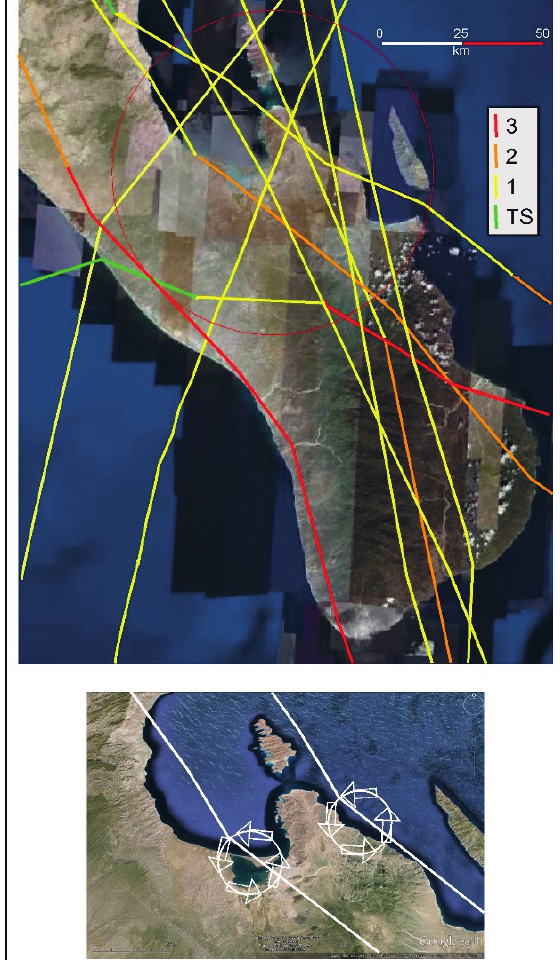
Figure 9. Hurricane history for the La Paz area. Displayed are the tracks of all tropical cyclones that approached within a 50 km radius (red circle) of the city of La Paz at hurricane strength from 1949 to 2014 (top). Five of the ten storms passed to the east of our site, much of their force blocked by the protruding peninsula along the southeastern edge of the bay. Cartoon at bottom shows the cyclonic circulation of hypothetical tropical cyclones with arrows pointing in the direction of wind flow for all four quadrants, demonstrating that storms passing to the west will generally result in an off- shore direction for wind/wave energy, and consequently sediment transport during the passage of the strong right front quadrant. Force of storms passing to the east will be dampened by the intervening